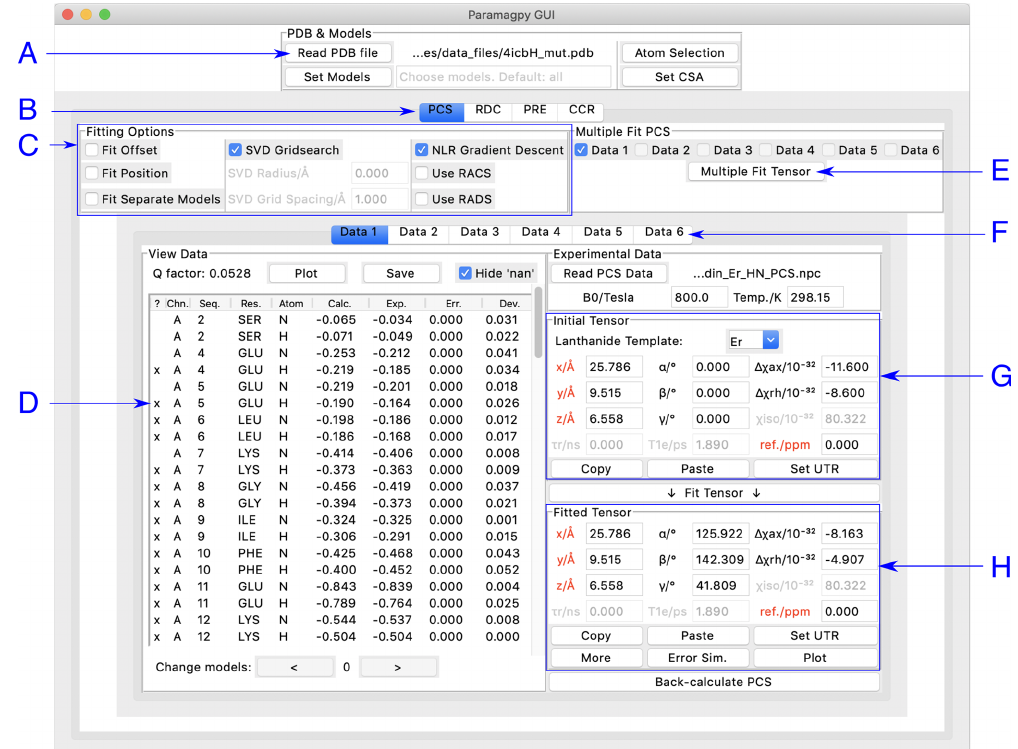
Figure 1. Paramagpy GUI running on Mac OS X. (A) Frame for loading PDB coordinates. The atoms and models (conformers) of interest can be selected and CSA-tensor parameters set by the user. (B) The user can switch between PCS, RDC, PRE and CCR tabs, where CCR stands for the Curie-spin–dipole–dipole cross-correlated relaxation. (C) Fitting options can be specified by selecting the relevant check box. The “SVD Gridsearch” option searches for the best-fit tensor within a sphere about the initial tensor origin with radius and grid spacing as specified. The “NLR Gradient Descent” option refines the tensor using non-linear least-squares minimisation. (D) Experimental data for atoms in the PDB file are displayed here. The first column contains an “x” if the datum will be used during fitting and may be toggled by pressing the “x” key on the keyboard. Experimental and back-calculated PCS values are also reported and their correlation can be displayed by clicking the “Plot” button above. (E) To utilise multiple PCS data sets to fit different tensors to a common position, the “Multiple Fit Tensor” button can be clicked after selecting the desired data sets. (F) Each tab can contain a different PCS data set, allowing up to 6 to be loaded. If more data sets are required, Paramagpy supports this through the scripted module. (G) The initial tensor parameters can be specified here to define a starting point before fitting. For convenience, the paramagnetic centre can be positioned at any atom in the PDB file by double-clicking on a row of the data view in the frame to the left. Parameters in red are constrained during fitting. Greyed out parameters are not relevant to PCS or RDC calculations, but are used in PRE and CCR calculations. (H) The fitted tensor is displayed here. Clicking the “Copy” button allows the tensor to be pasted into other tabs of the program (see B and F above). The “Plot” button will prompt the user to save an isosurface file for opening in PyMOL. “Error Sim.” will assess the quality of the fit by bootstrap or Monte Carlo methods. The button “Set UTR” is for conversion of the tensor parameters to the unique tensor representation defined by the program Numbat (Schmitz et al.,